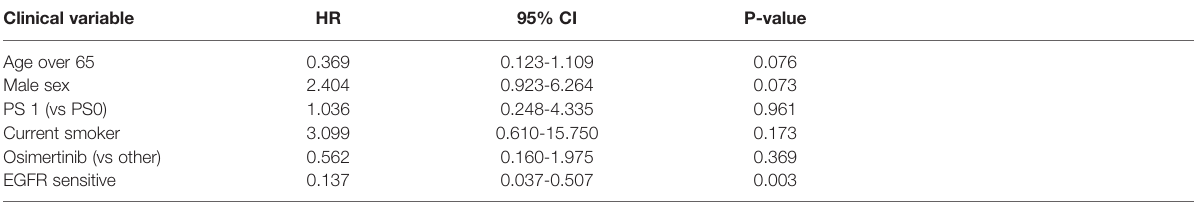
TABLE 2B | Multivariable PFS.